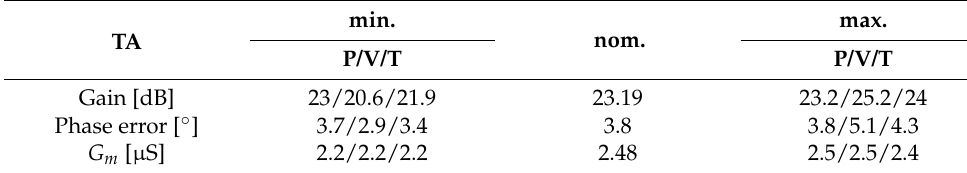
Table 3. The PVT corner analysis results for the DDCC. min. max. DDCC Figure 11. The TA histogram of the gain ( a ) and phase error ( b ). Figure 11. The TA histogram of the gain ( a ) and phase error ( b ). Table 4. The PVT corner analysis results for the TA. The process, voltage, temperature (PVT) corners analysis was also provided on the proposed DDTA. The MOS transistor corners were slow-slow, slow-fast, fast-slow, and min. max. nom. TA Table 4. The PVT corner analysis results for the TA. fast-fast, the voltage supply corners were (V DD − V SS ) ± 10%, and the temperature corners were − 20 °C and 70 °C. Tables 3 and 4 show the results of the minimum, nominal, and min. max. TA nom. maximum values of the gain, − 3 dB BW for the DDCC, and gain and phase error for the TA. The impact of the PVT corners in all cases is acceptable .